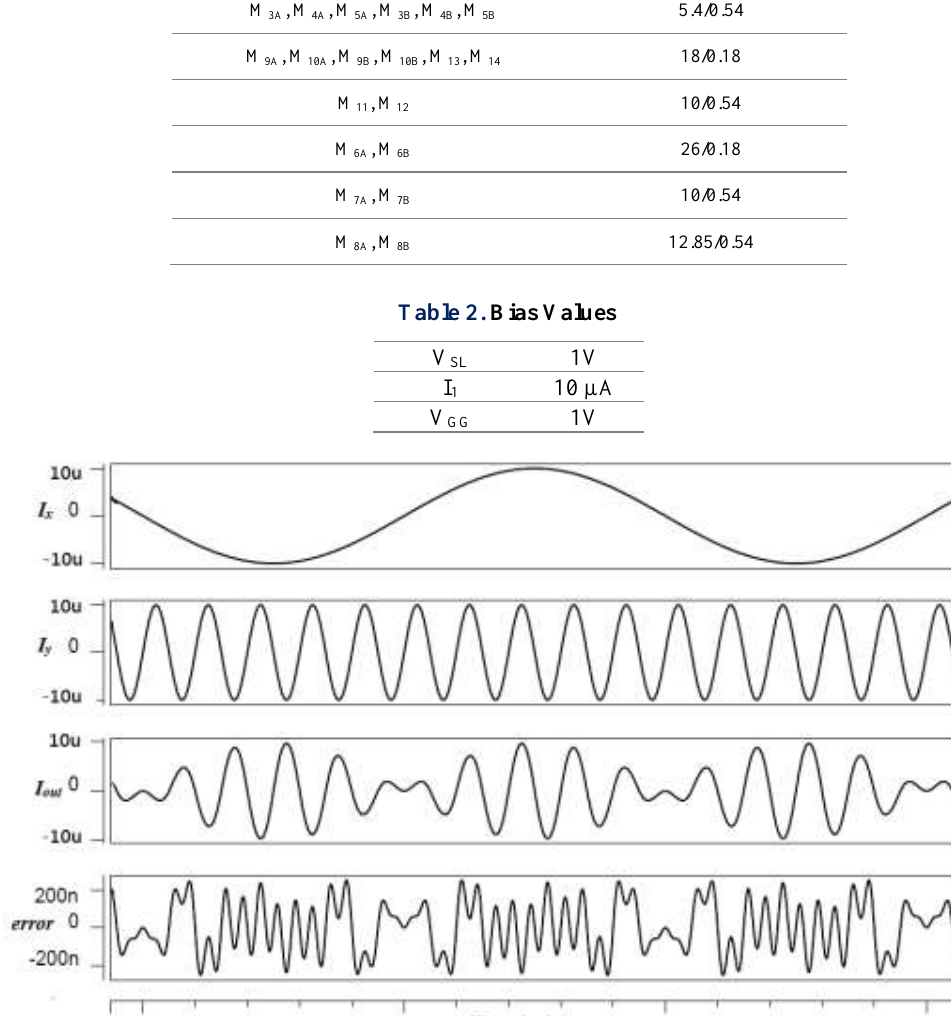
Table 1. Aspect Ratio of Figure 1. MOSFETs in micrometer